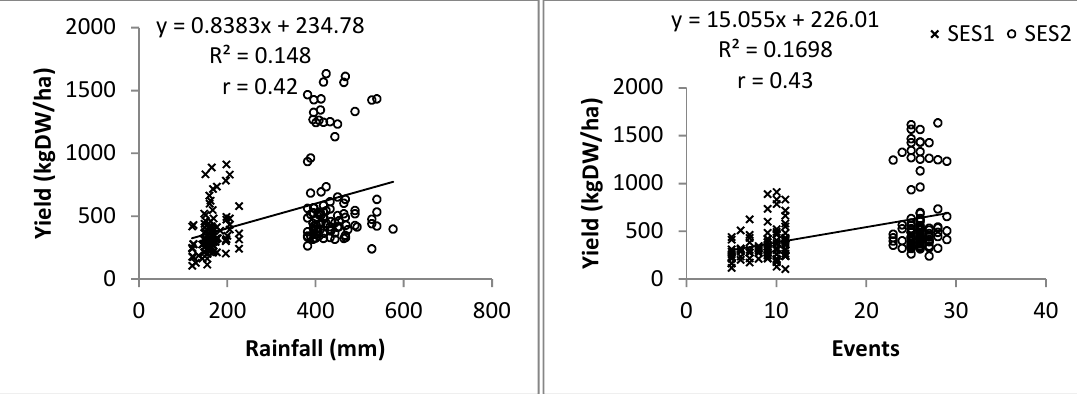
Figure 9. Combined relationships between two seasons of yields (kgDWha −1 ), seasonal rainfall (mm) amounts, and number of events.